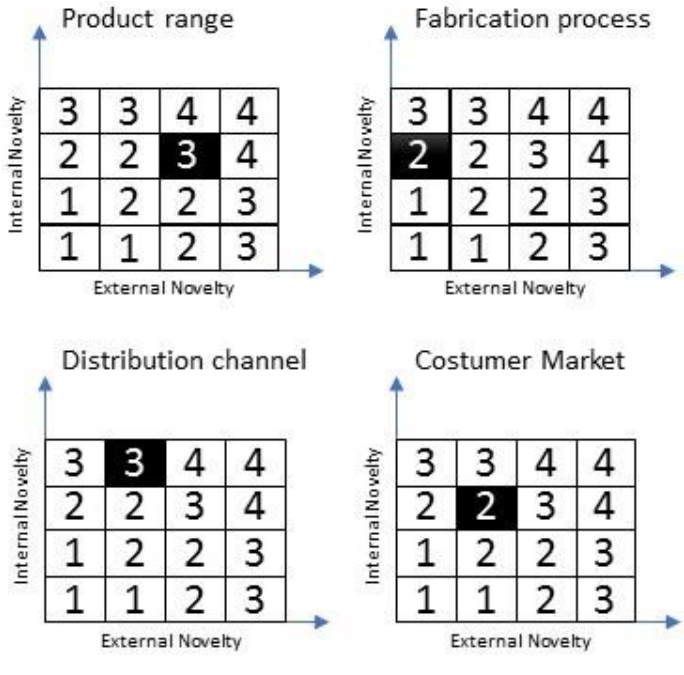
Figure 6. Characterization of project B.